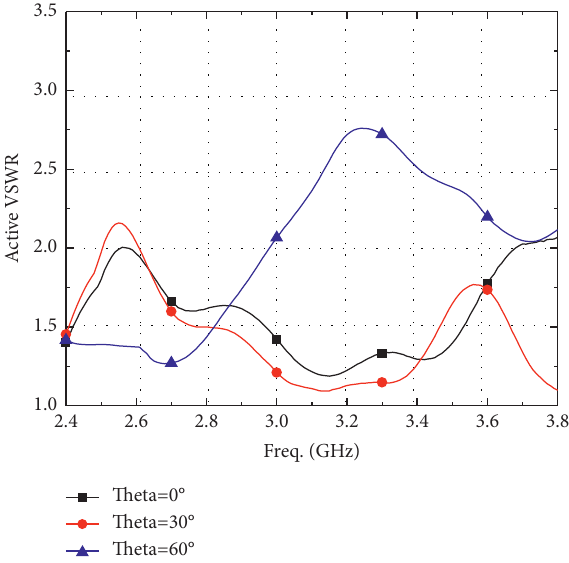
Figure 11: Active VSWR under different scanning angles along the H -plane (no. 5).